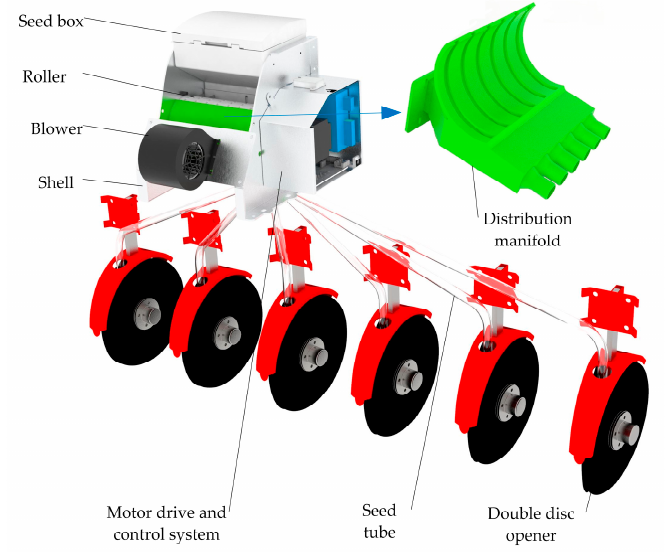
Figure 1. Structural diagram of planter.